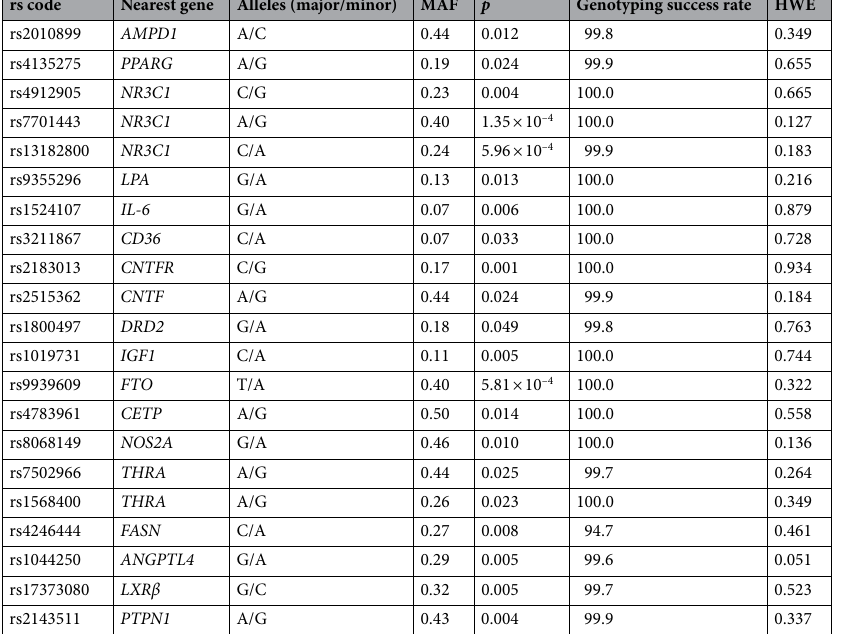
Table 1. Main characteristics of the 21 single nucleotide polymorphisms (SNPs) included in the genetic risk score. Association of SNPs in relation to body mass index (BMI) displayed in p values ( p ). AMPD1 (Adenosine Monophosphate Deaminase 1); ANGPTL4 (Angiopoietin like protein 4); BMI (Boy Mass Index); CD36 (cluster of differentiation 36); CETP (Cholesteryl ester transfer protein); CNTF (Ciliary Neurotrophic Factor); CNTFR (Ciliary Neurotrophic Factor Receptor); DRD2 (Dopamine Receptor D2); FASN (Fatty acid synthase); FTO (Fat mass and obesity-associated gene); HWE (Hardy–Weinberg Equilibrium); IGF1 (Insulin Like Growth Factor 1); IL-6 (Interleukin-6); LPA (Lipoprotein A); LXRB (Liver X receptor beta); MAF (Minor allele frequency); NOS2A (Nitric oxide synthase 2); NR3C1 (Nuclear receptor subfamily 3, group C, member 1); PPARG (Peroxisome Proliferator Activated Receptor Gamma); PTPN1 (Protein Tyrosine Phosphatase Non- Receptor Type 1); THRA (Thyroid Hormone Receptor